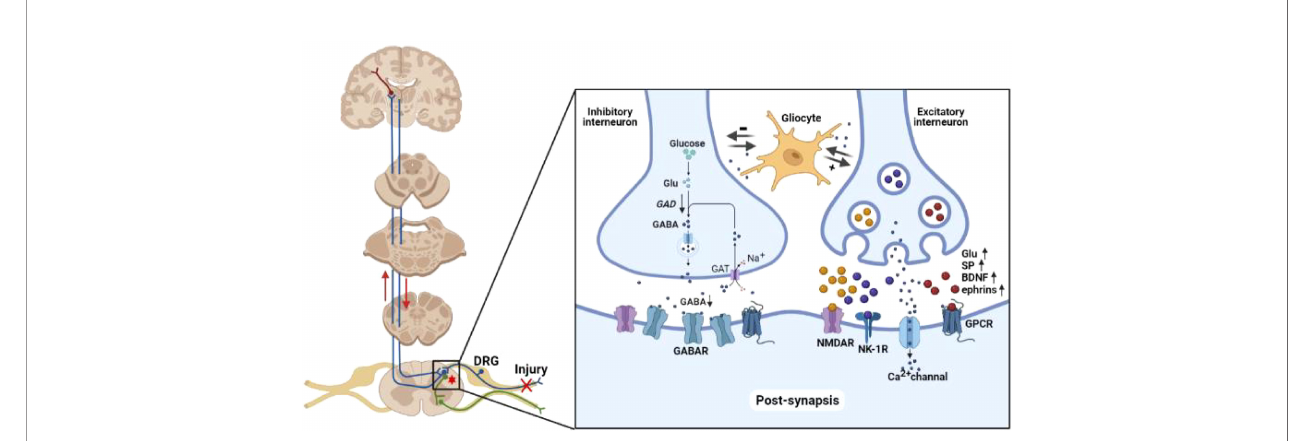
FIGURE 1 | Neuropathology of neuropathic pain. Peripheral nociceptive stimuli are converted into electrochemical signals by pain receptors and transmitted to the brain through the spinal cord via upward projection fi bers. The spinal cord also relays downward signal to regulate the nociceptive signal transmission. The imbalance of inhibitory/ excitatory interneurons forms the basis of neuropathic pain. In inhibitory interneurons, GABA is synthesized from glutamate by GAD and released into the synaptic cleft. GABA in the synaptic cleft is taken up by interneurons via GABA transporters in a Na + -dependent mechanism. Chronic nerve injury reduces the activity of GABA synthase and GAD, ultimately resulting in disinhibition. Chronic nerve injury enhances the synthesis of glutamate, SP, BDNF and ephrins in excitatory interneurons. These neurotransmitters enhance the spontaneous excitatory postsynaptic currents mediated by AMPAR, NMDAR, NK-1R, and Ca 2+ channel on postsynaptic membrane. Glu, glutamate; GAD, glutamic acid decarboxylase; GABA, g -aminobutyric acid; GAT, GABA transporter; SP, substance P; BDNF, brain derived neurotrophic factor; NMDAR, N-methyl-D-aspartate receptor; NK-1R, neurokinin 1 receptor; GPCR, G protein-coupled